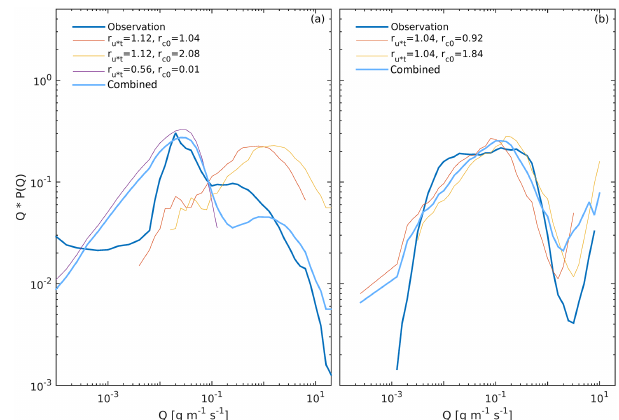
Figure 11. (a) Probability density functions of observed Q and sim- ulated Q for 1min averages with several choices of r u as (a) but for 30min